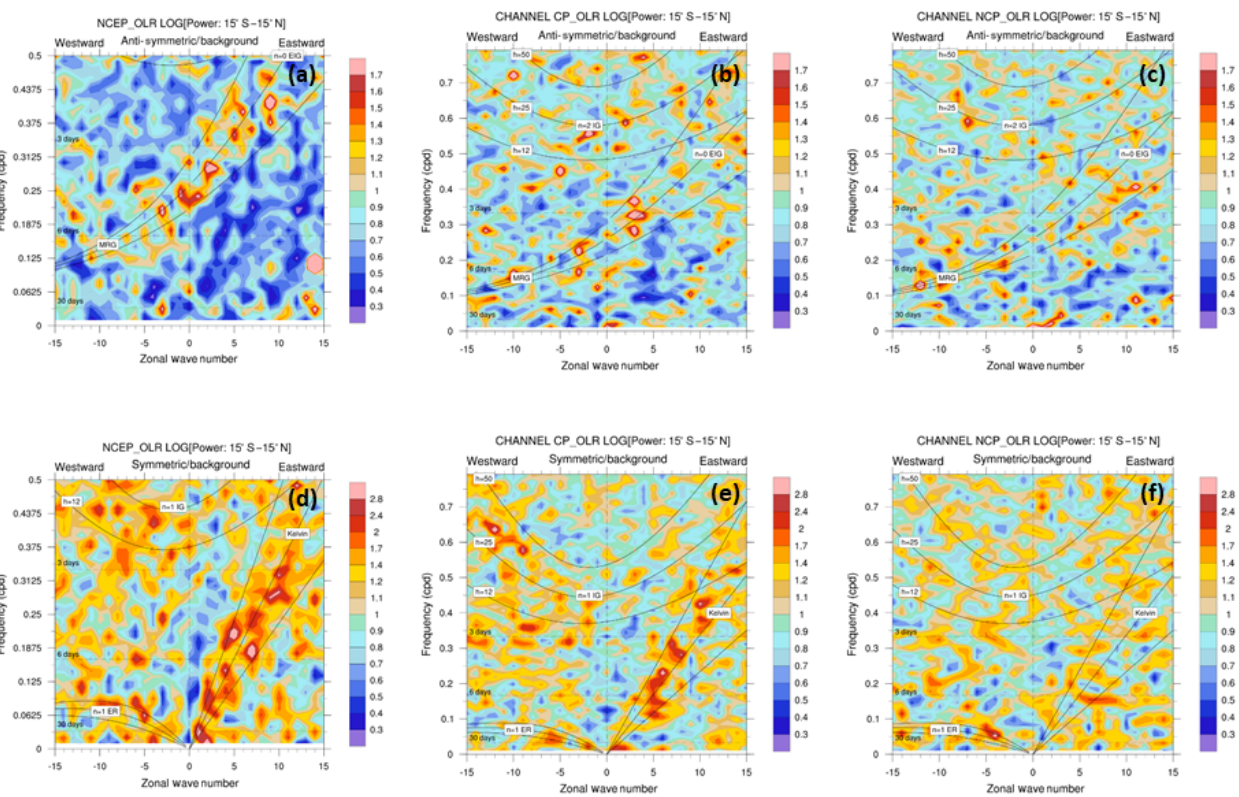
Figure 3. Wheeler–Kiladis diagrams of the TOA OLR averaged over the latitude belt of ± 15 ◦ around the Equator and sampled with a temporal resolution of 3h over April–June 2015. (a, d) Results achieved with the CERES data, (b, e) CP simulations, and (c, f) NCP resolution. (a–c) Anti-symmetric spectra and (d–f) symmetric